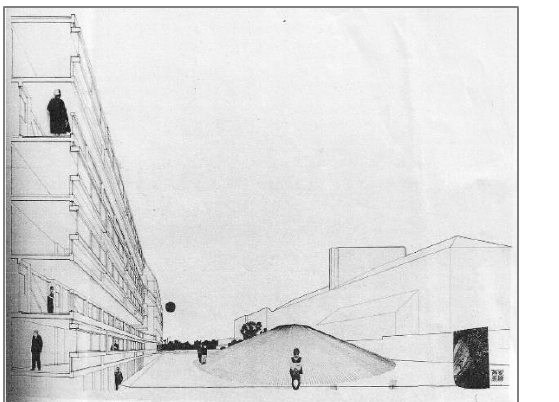
Figure 7 Alison and Peter Smithson (URL-4)